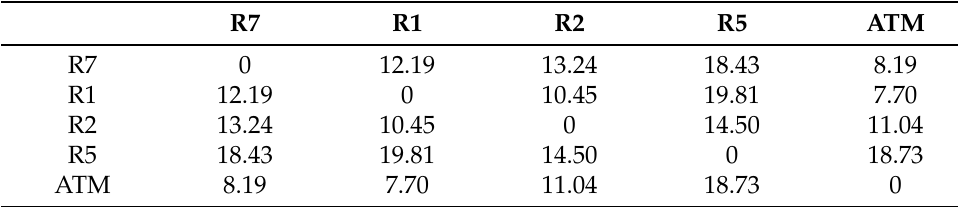
Table 3. Undirected graph of all selected